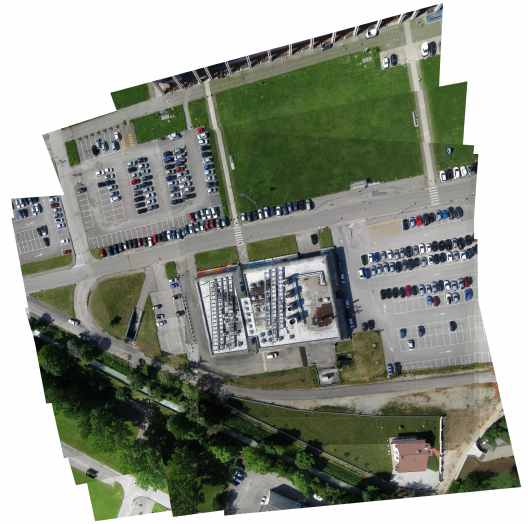
Figure 9. Dataset 2: Mosaic obtained after image alignment, with no colour correction and seamline